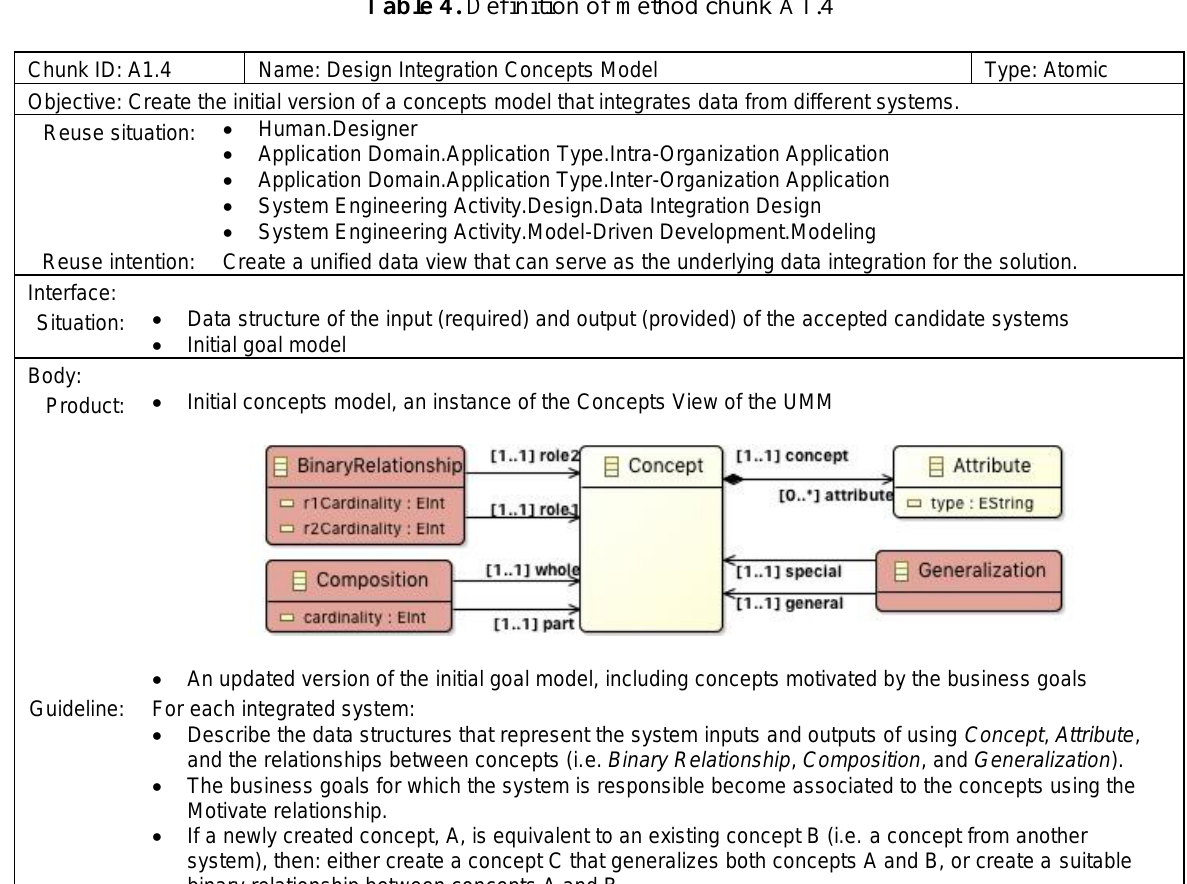
Table 4. Definition of method chunk